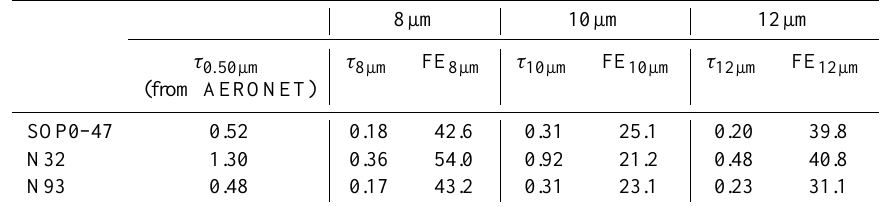
Table 4. Estimated dust optical depth and TOA forcing efficiency (FE, Wm − 2 τ − 1 ) at 8, 10, and 12µm for the SOP0–47, N32, and N93 cases (see text for details). The measured τ at 0.50µm from AERONET is also